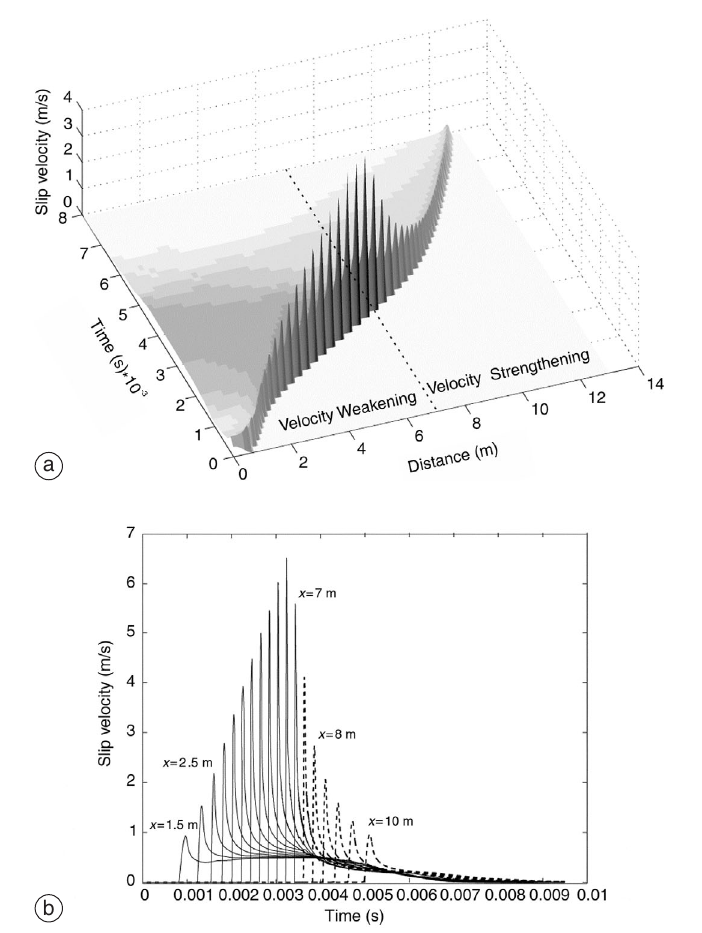
Fig. 8a,b. Dynamic rupture propagation along a heterogeneous fault: the adopted constitutive parameters are listed in table III. The fault is represented as two patches having different values of the a and b parameters ( a 1 , b 1 and a 3 , b 3 in table III): a velocity strengthening area is adjacent to the velocity weakening patch where the rupture nucleates. Panel a) shows the spatio-temporal evolution of slip velocity. Panel b) displays the time his- tories of slip velocity in different positions along the